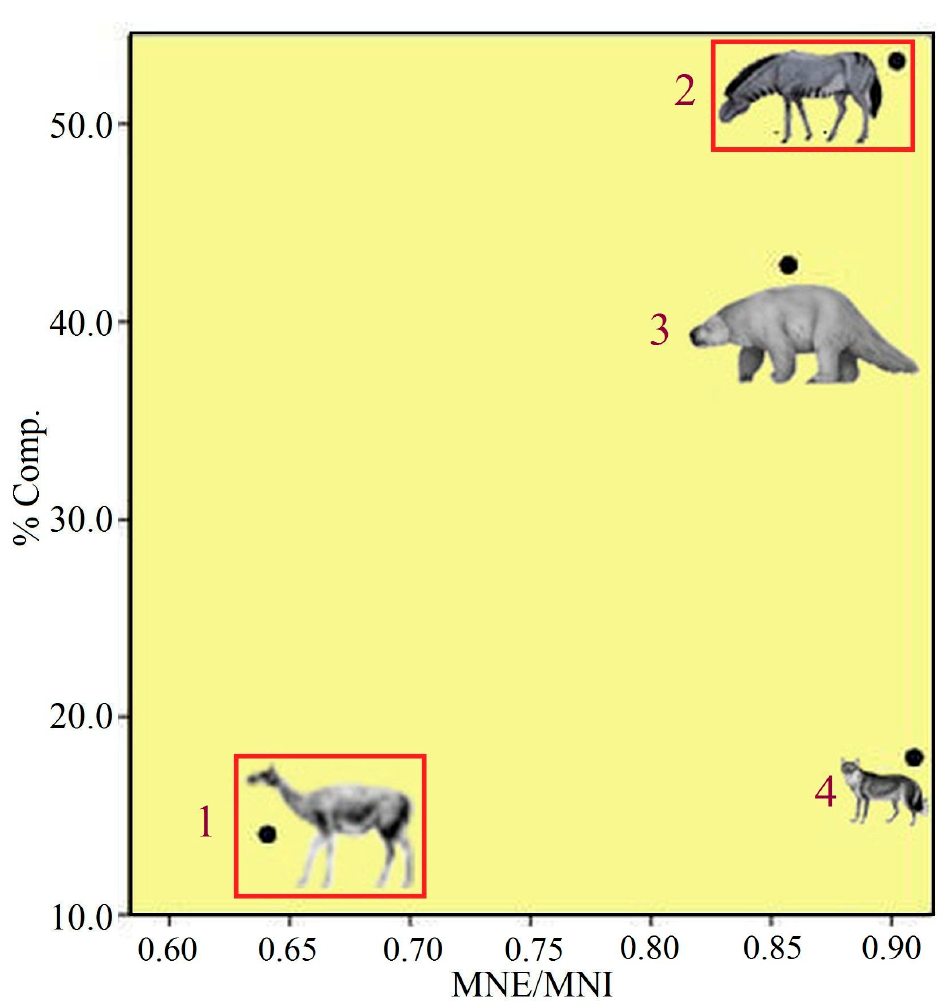
Figure 9. Images of a pile of bones placed ( a ) over a typical PA hearth with a concave base and a mandible of an infant horse placed on it ( b ).